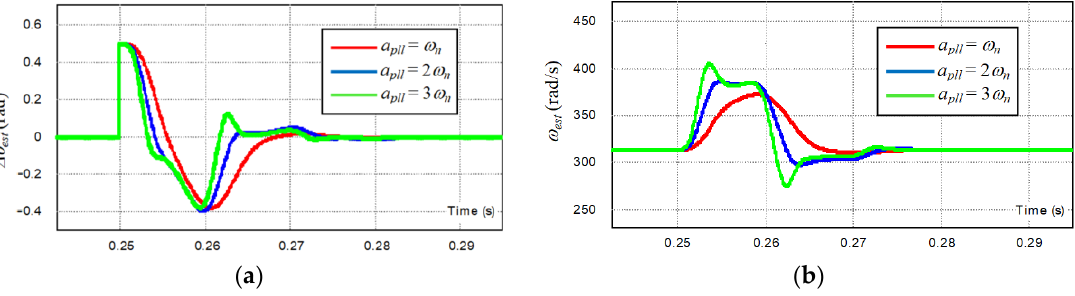
Figure 10. The estimated phase angle error ( a ) Δ θ est and estimated frequency ( b ) ω est for three different a pll values, for step input signal phase angle variation.